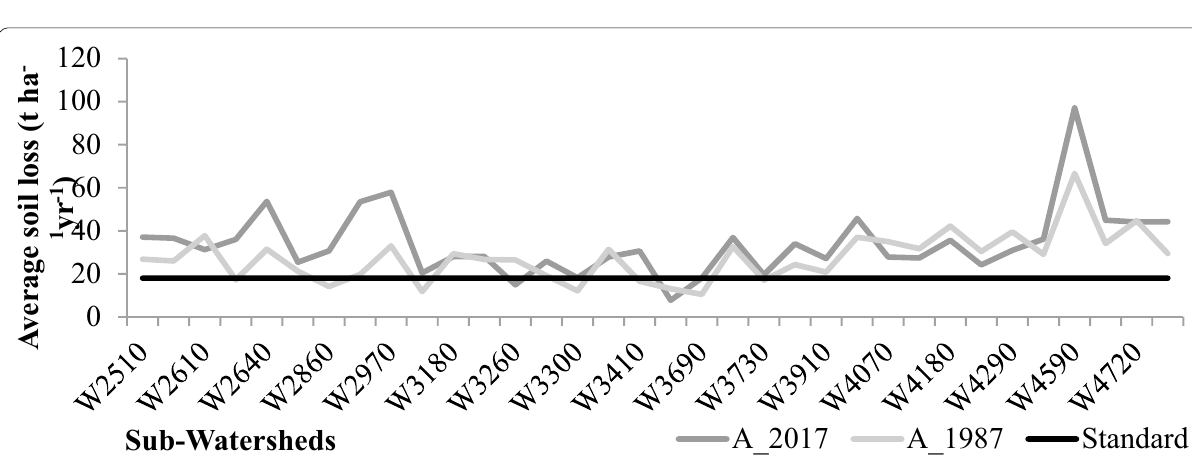
Fig. 17 Evaluation of mean soil loss from sub-watersheds with respect to national